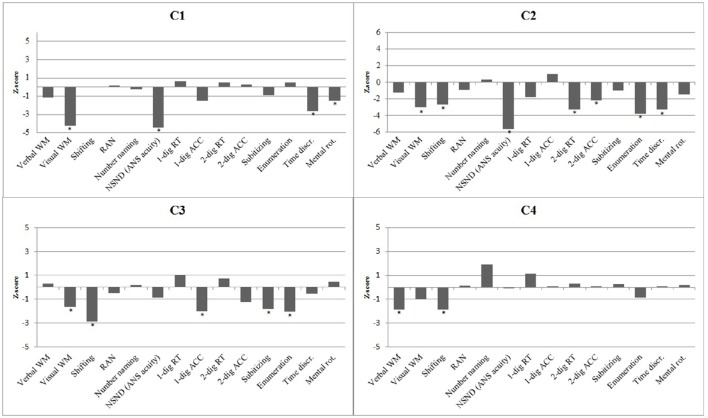
A histogram of the performances (z-scores) of the four cases with DD on domain-general cognitive processing and magnitude processing. Statistically significant impairments are shown with asterisk.